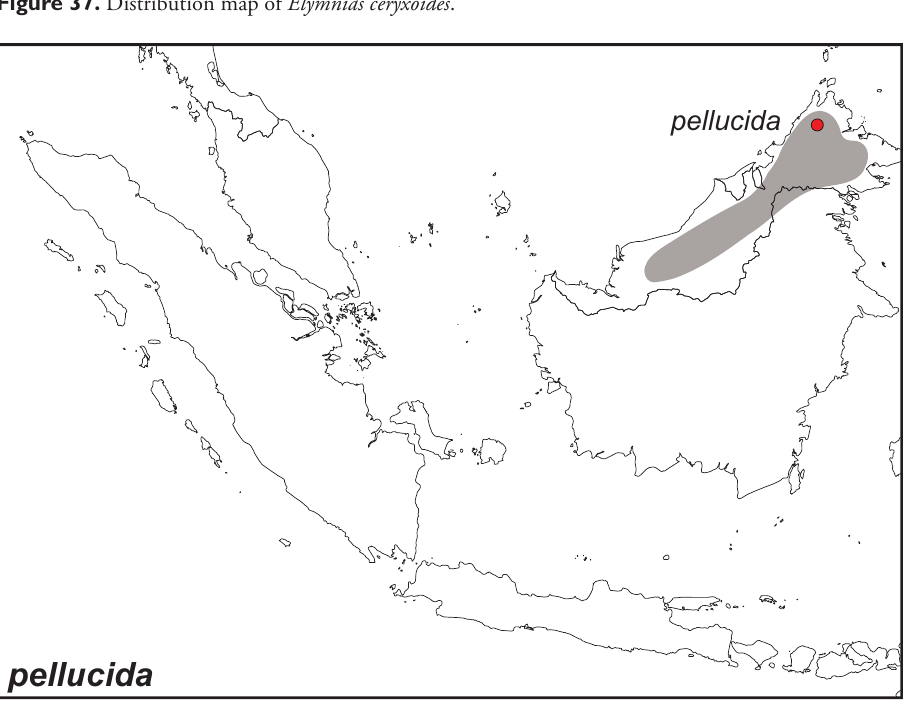
Figure 38. Distribution map of Elymnias pellucida